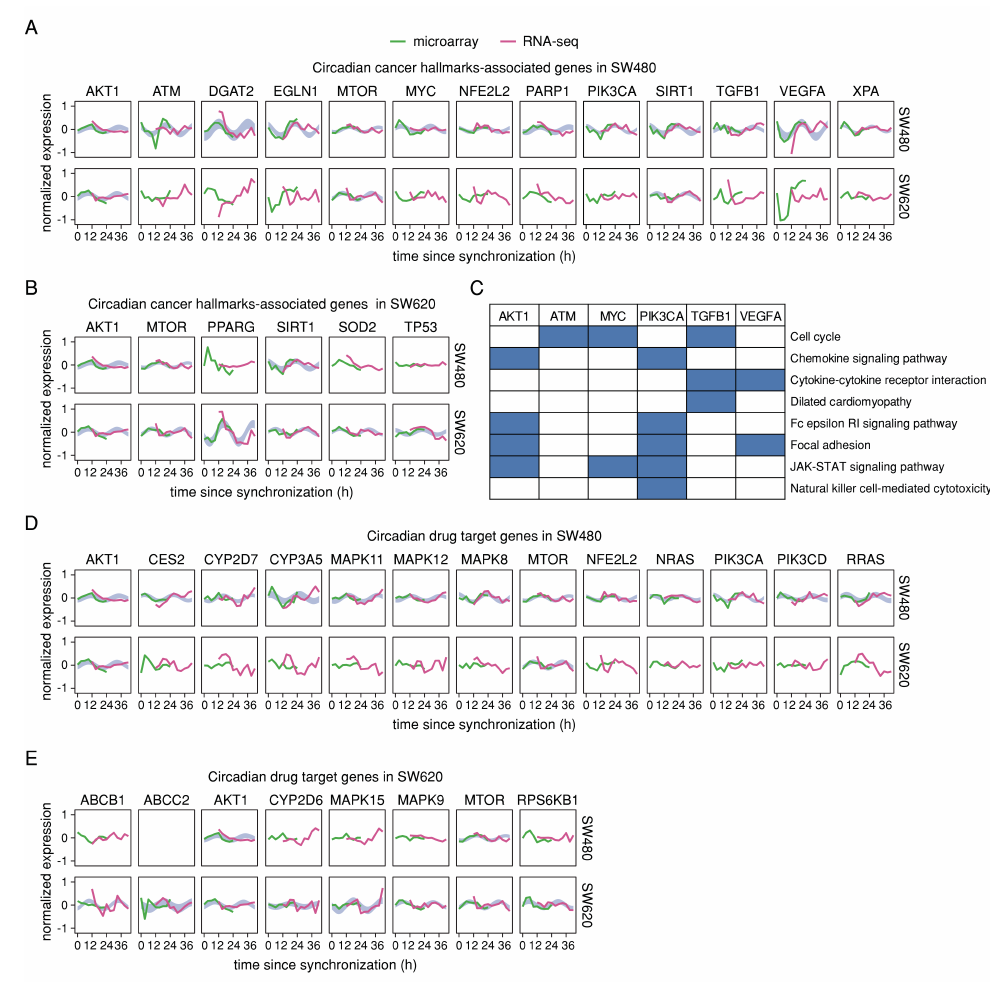
Figure 5. Cancer hallmark-associated and drug target genes show di ff ering oscillatory expression in SW480 and SW620 cells. Normalized time series expression of cancer hallmark-associated genes identified as 24 h rhythmic in ( A ) SW480 and ( B ) SW620 cells based on the concatenated data. ( C ) Phase-clustered circadian KEGG pathways in which cancer hallmark-associated genes are involved in SW480 cells. Normalized time series expression of drug target genes identified as 24 h rhythmic in ( D ) SW480 and ( E ) SW620 cells based on the concatenated data. Microarray expression values are represented by green lines and RNA-seq expression values by pink lines. The respective top row shows the expression in SW480 cells and the respective bottom row in SW620 cells. The blue area marks the confidence area of the harmonic regression fitted to the concatenated data for 24 h rhythmic